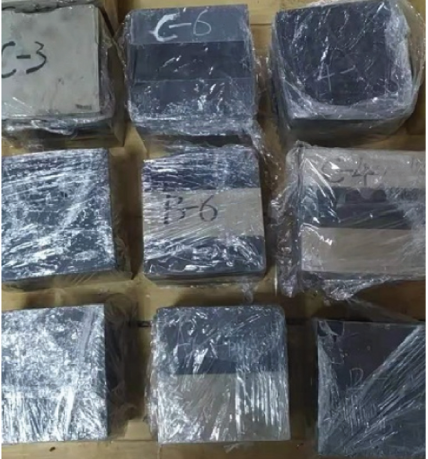
Figure 1: Coal-gangue interbed